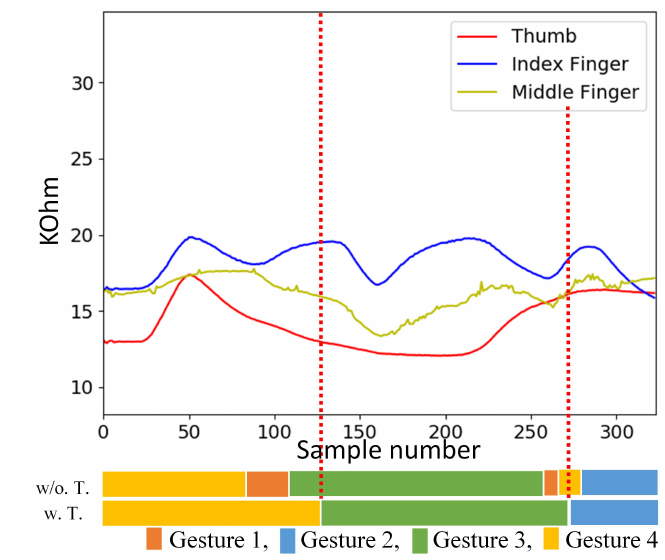
Figure 19. An example of a testing sequence produced by flex sensors consisting of three finger gestures (Gesture 4, Gesture 3, Gesture 2) back to back. The results of gesture spotting with and without the inclusion of transitions for training are shown in the bottom. The w. T. and w/o. T. denote the training operations with and without transitions, respectively. Table 5. Comparisons of the confusion matrix on the testing set for the proposed algorithm with (denoted by w. T.) and without (denoted by w/o. T.) the inclusion of transitions for training. Gest.